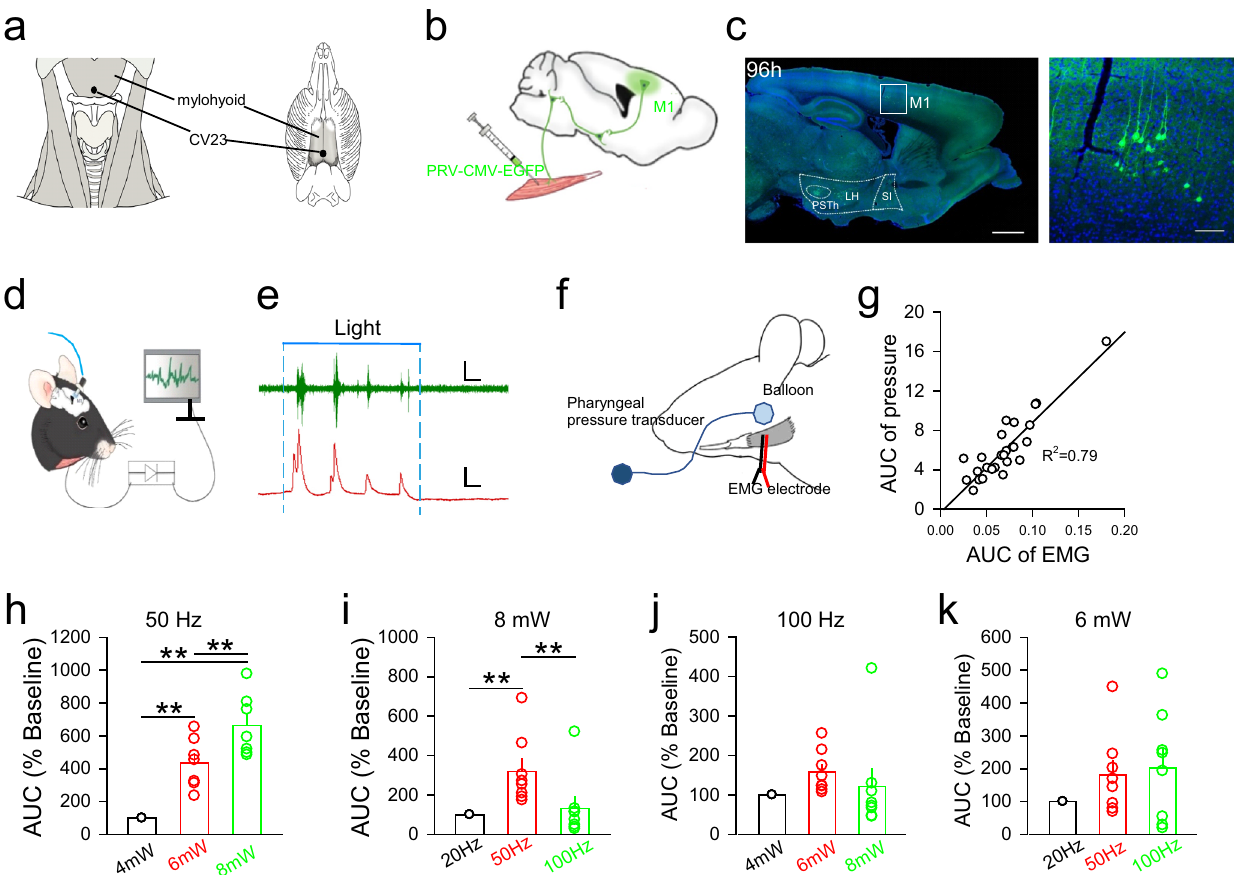
Fig.1|OptogeneticactivationofM1L5neuronscontrolledmylohyoidactivity. a The position of CV23 acupoint in the coronal plane in humans (left) and